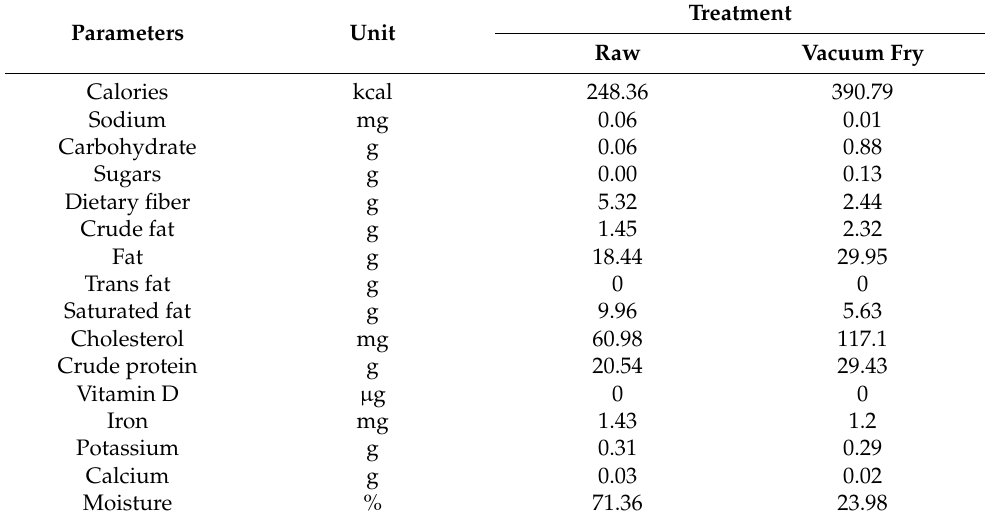
Table 2. Nutritional value in 100 g of chub mackerel ( Scomber japonicus ) after vacuum frying.